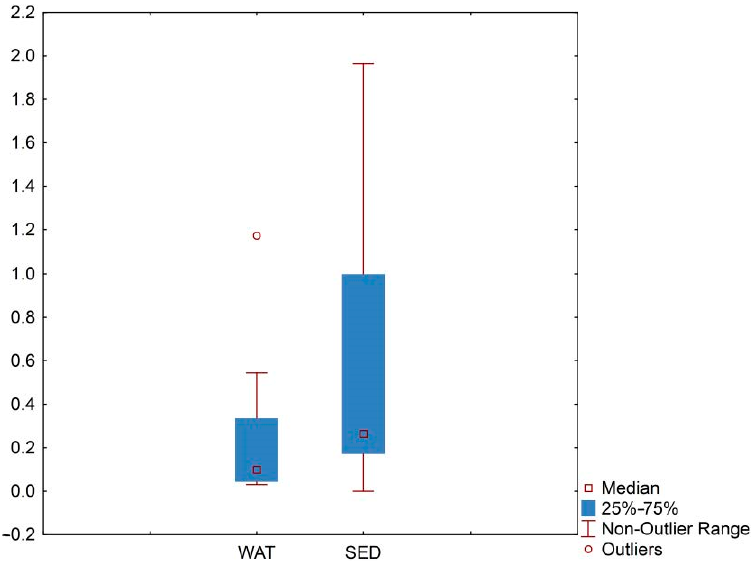
Figure 4. Boxplot comparing the concentration of plastic items found in water and riverbed sediments.